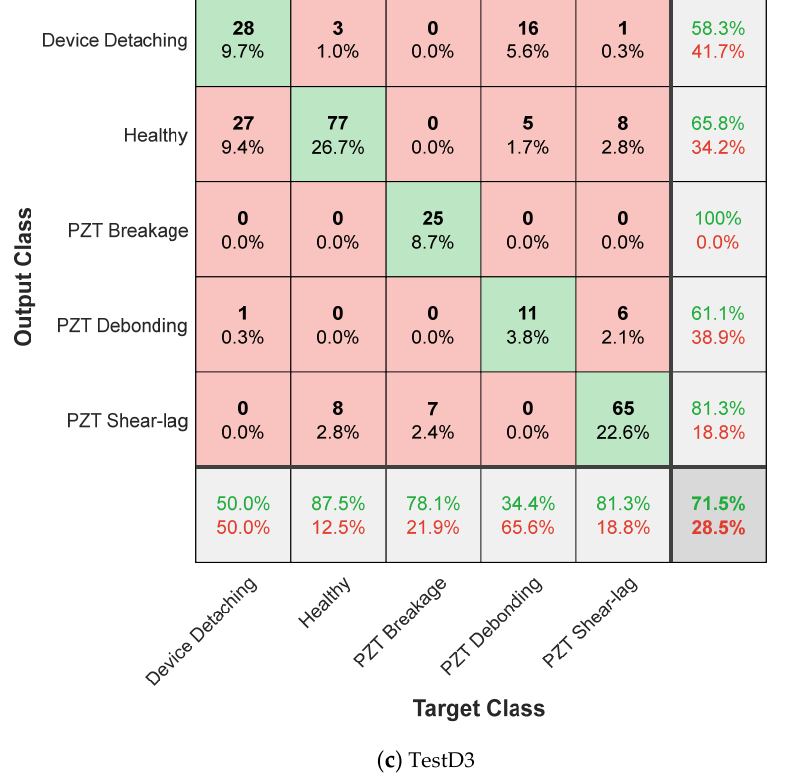
Figure 17. Testing accuracy of the 1D CNN ‐ based fault detector.